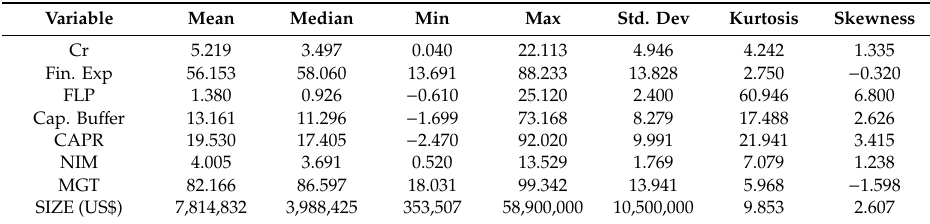
Table 3. Summary Statistics of Bank specific